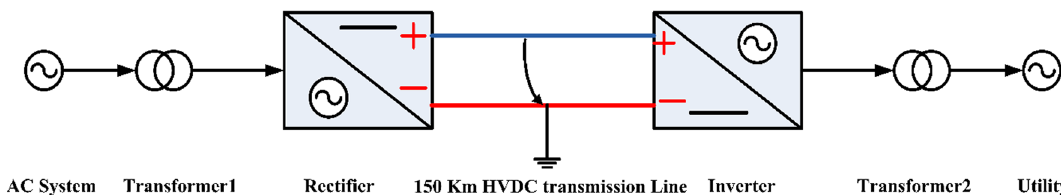
Fig. 5 Short circuit fault among positive, negative and ground (PNG) on HVDC system